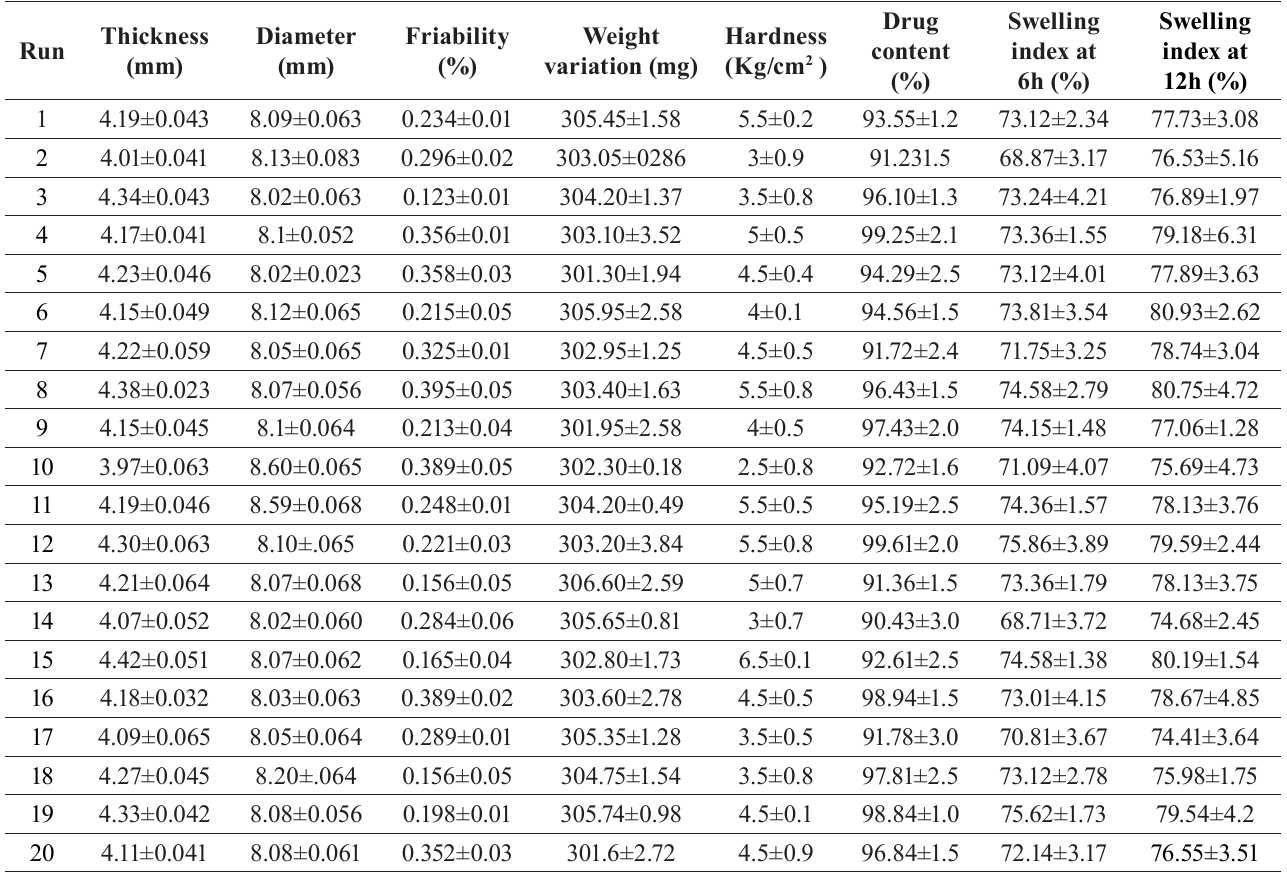
TABLE IV - Characterization of prepared tablets suggested by CCD